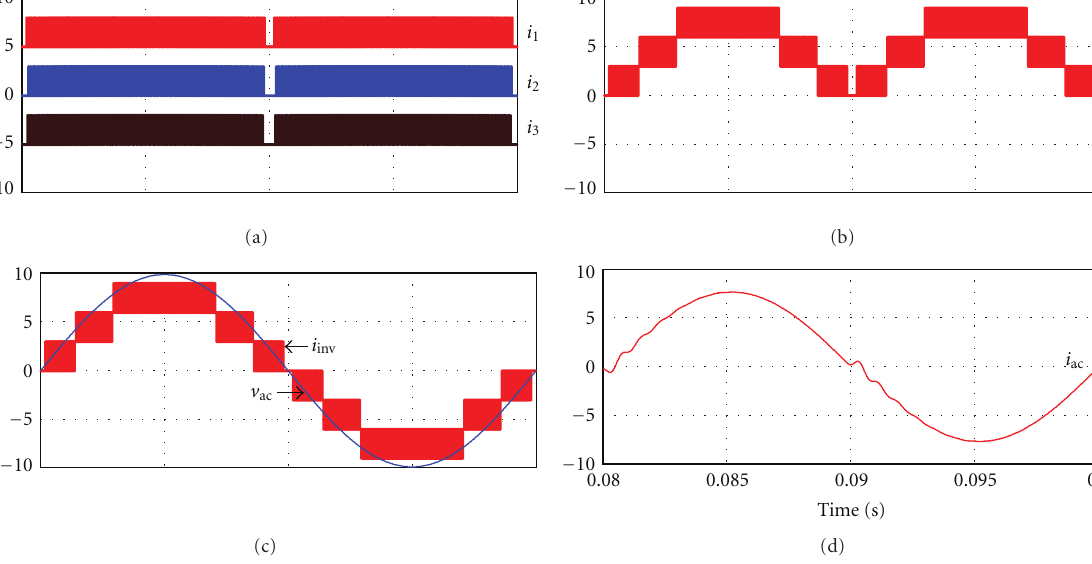
i i i i v i 1 , 2 , 3 , dc , inv , ac , and ac